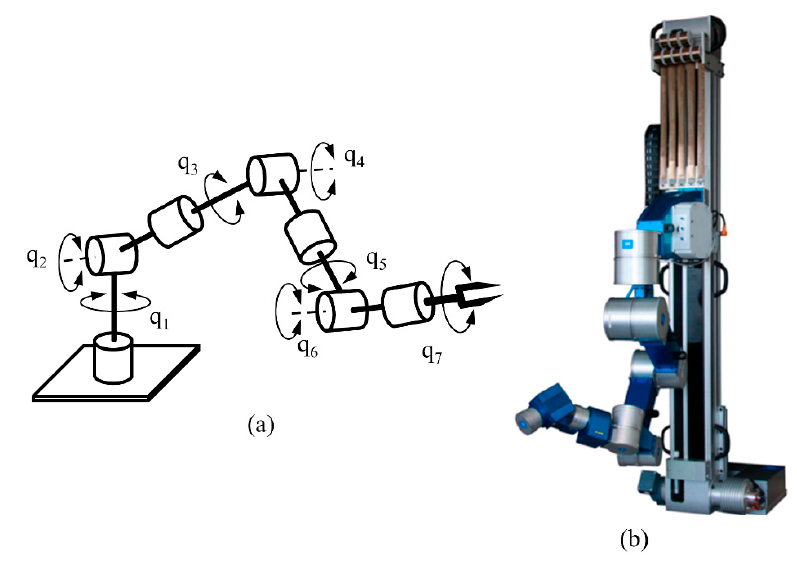
Figure 4. ( a ) Serial and redundant manipulator structure—q i indicates a degree of freedom; ( b ) redundant manipulator—courtesy of CROPS (Intelligent sensing and manipulation for sustainable production and harvesting of high value crops: clever robots for crops) consortium and Prof. D. Rixen, Technical University of